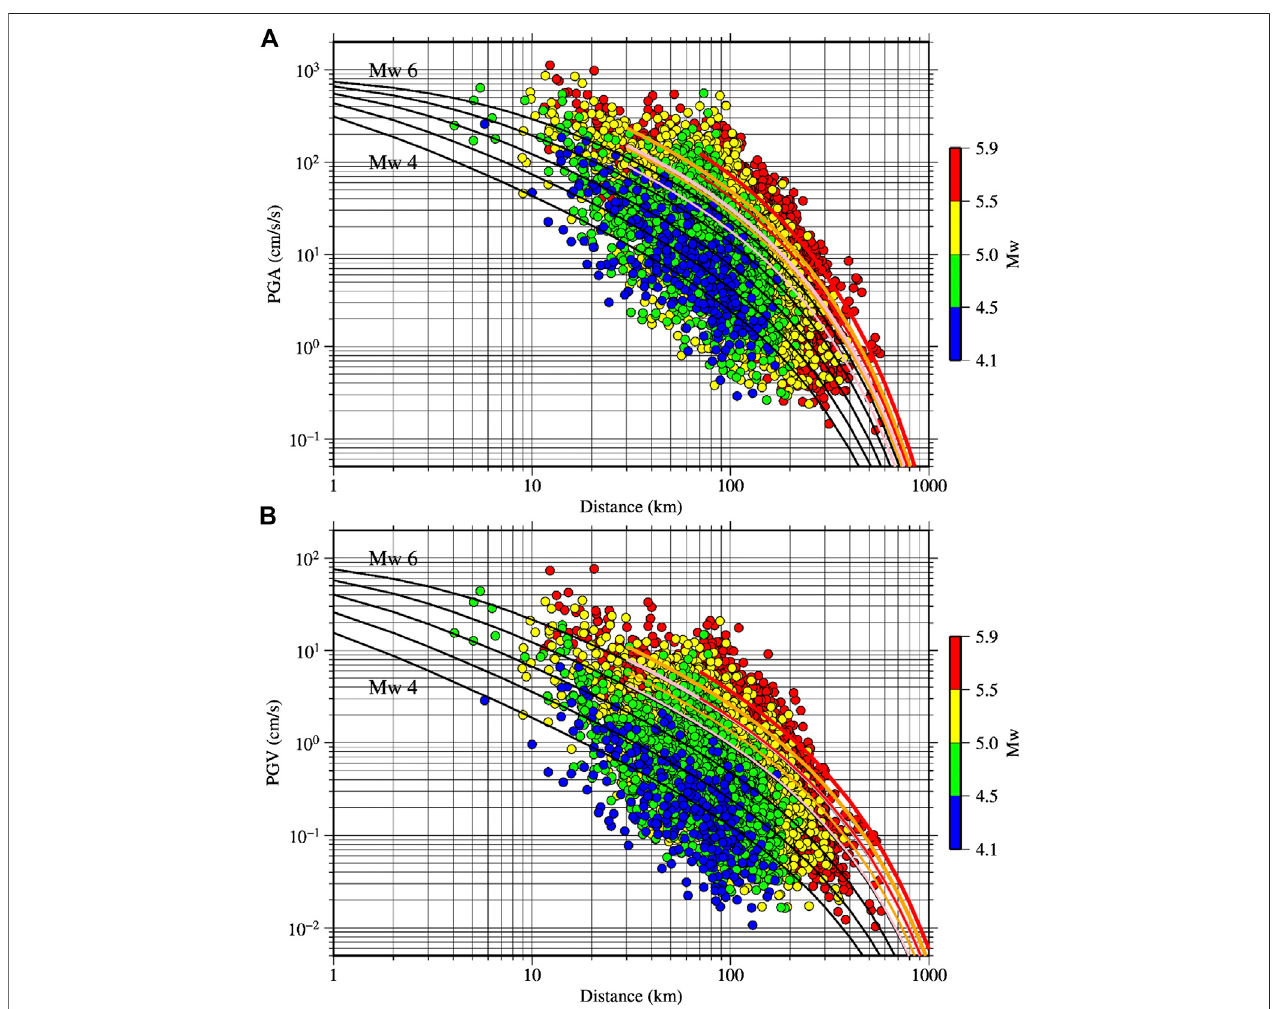
FIGURE 3 | Plot of PGAs (A) and PGVs (B) as a function of hypocentral distance. The black curved lines denote the median prediction curves for crustal earthquakes for soil site conditions in (A) and Vs30 (cid:2) 300 m/s in ( B ) for Mw (cid:2) 4.0, 4.5, 5.0, 5.5, and 6.0, respectively, using the GMPEs inSi and Midorikawa (1999). The thin and thick pink (orange) lines denote the median prediction curves for interplate (intraslab) earthquakes of Mw (cid:2) 5.5 and 6.0, respectively (focal depth (cid:2) 30 km). Similarly, the thin and thick red lines denote the median prediction curves for intraslab earthquakes of Mw (cid:2) 5.5 and 6.0, respectively, for focal depth (cid:2) 70